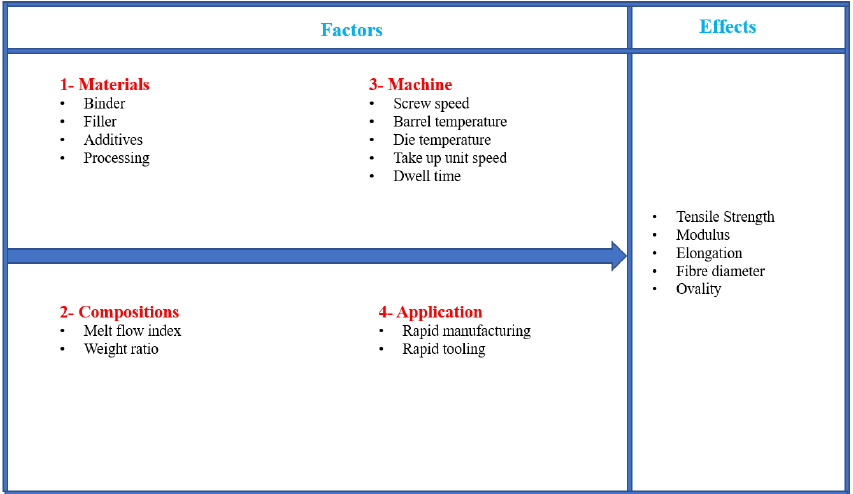
Figure 1. Effect of different factors on mixes of materials added to the extruder (adapted from Boparai et al. [19]).